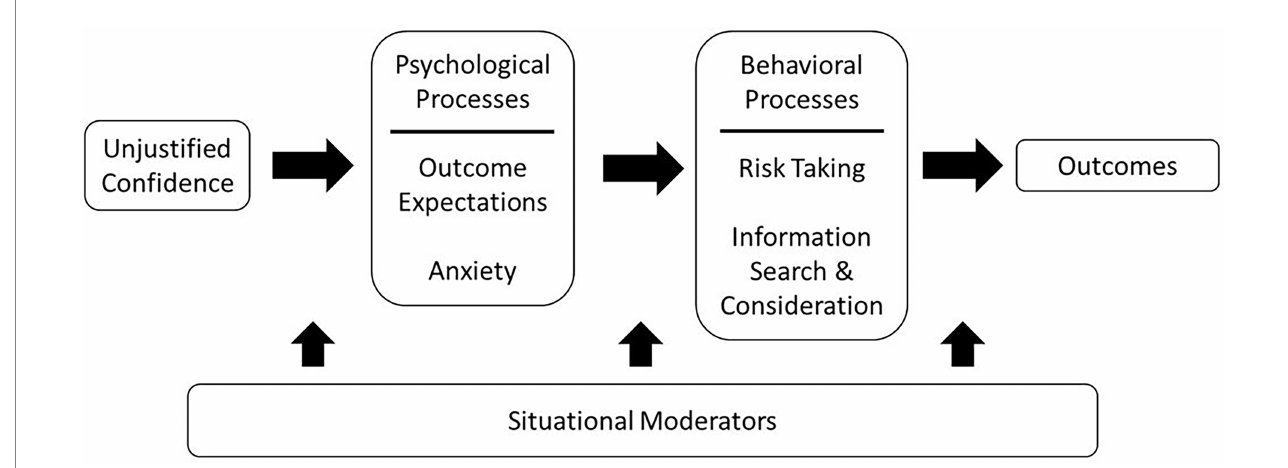
FIGURE 1 Proposed effects of unjustified confidence on psychological processes, behavioral processes, and subsequent decision